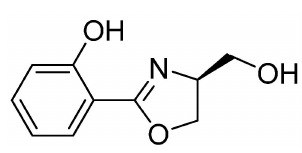
Figure 1. The structure of ( ´ )-Yanglingmycin.